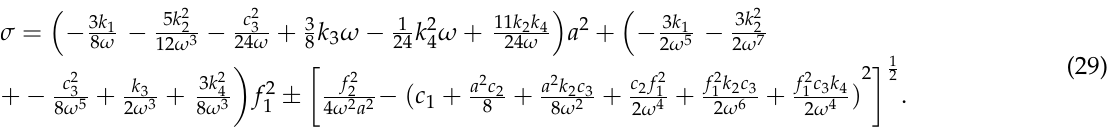
Figure 3. Amplitude of the response as a function of the load’s amplitude of primary resonance for 0  = .